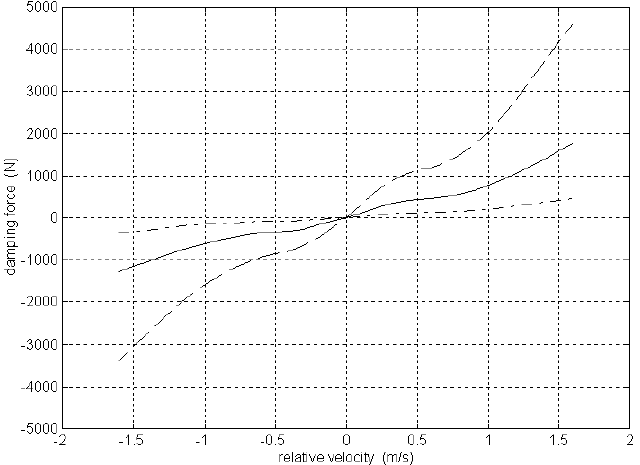
Figure 4. Nonlinear damping characteristics (solid: passive, dashed: max., dashdot: min.).